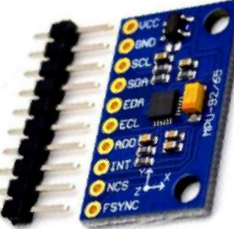
Figure 10. The 9 DoF IMU, MPU-9250 breakouts [30].